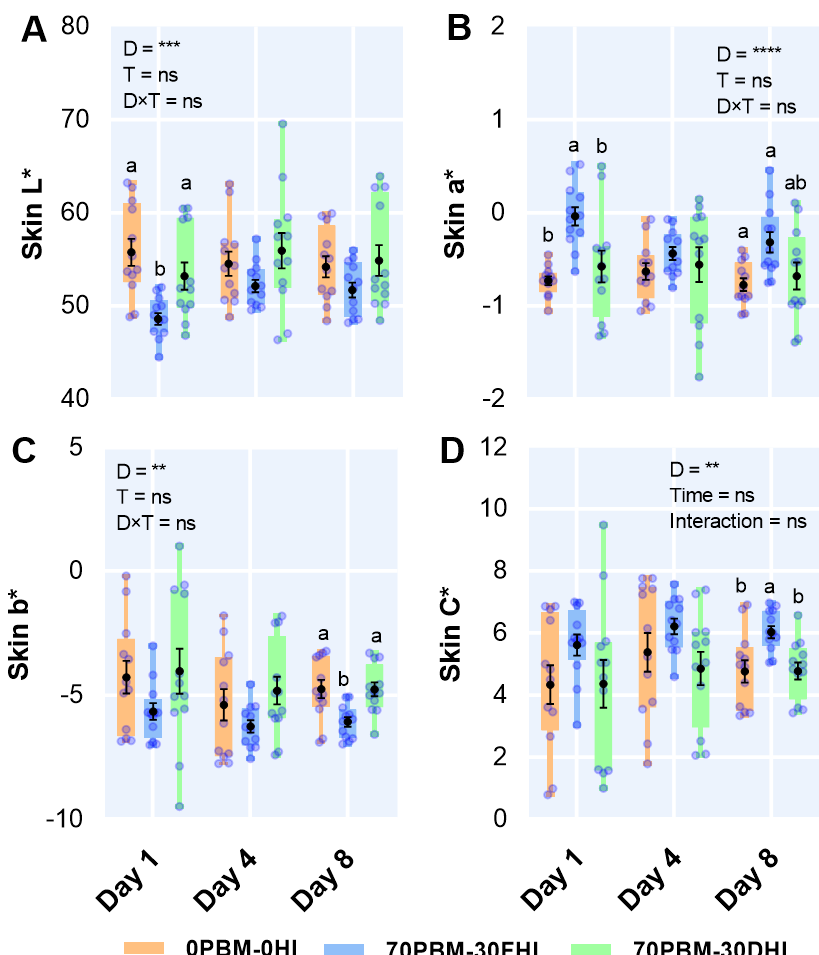
Figure 3. Changes in the fillet skin color, including the lightness (L*) ( A ), redness (a*) ( B ), yellowness (b*) ( C ), and chroma ( D ) levels, after the 8-week feeding trial and at day 1, day 4, and day 8 when stored at 4 °C in barramundi fed a complete replacement of fishmeal (FM) diet with mixtures of poultry by-product meal (PBM), full-fat Hermetia illucens (FHI), and partially defatted Hermetia illucens (DHI) larvae meal. Semi-transparent light blue round markers indicate individual datapoints ( n = 12), while the box–whisker plot of individual datapoints and black markers denote the mean and standard error values, respectively. Lower cases indicate significant differences between the treatments, while upper cases in the figure indicate significant differences between the storage days. Asterisks represent the significant differences at ** p < 0.01, *** p < 0.001 and **** p < 0.0001 and ns denotes non-significant.